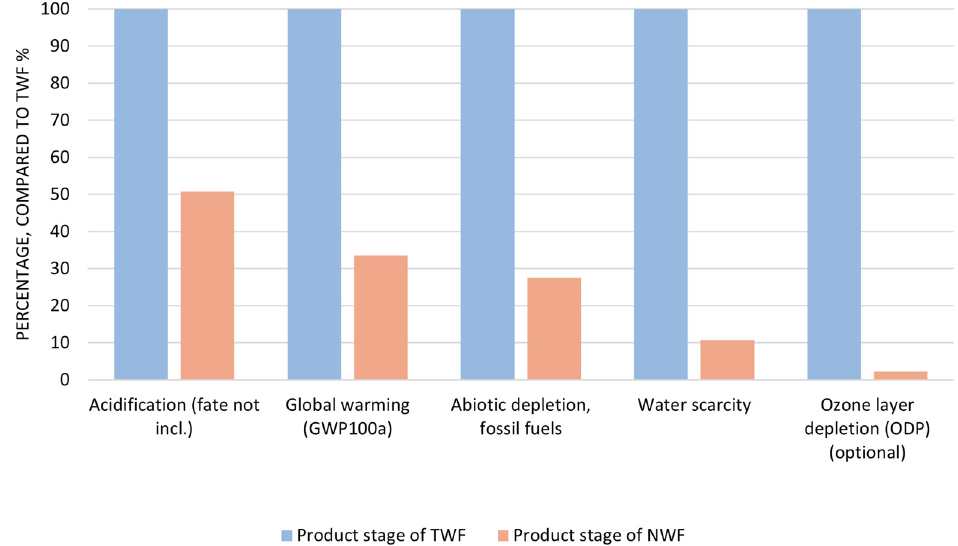
Figure 2. Comparing the “Product stage“ for functional unit (FU) (1 m 2 ) of façade elements made of thermally modified wood and non-heat-treated wood by the EPD method (2018) V1.01. TWF—thermally modified wood façade, NWF—non-heat-treated wood façade.